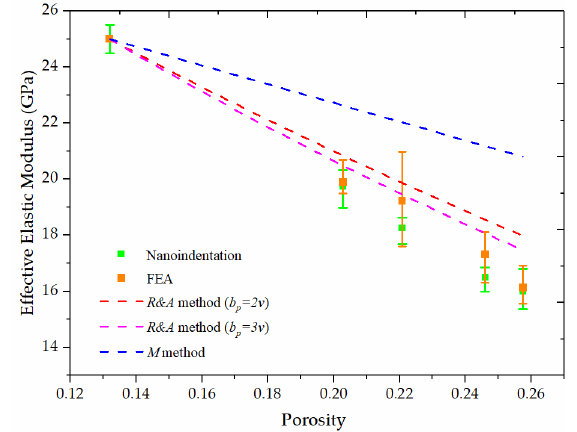
Figure 17. Effective elastic modulus degradation with porosity.